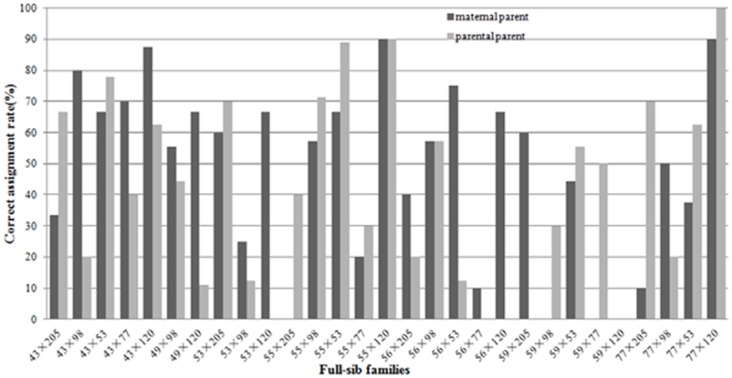
Correct maternity and paternity assignment rate of 257 control-pollinated individuals in 29 full-sib families in a Larix gmelinii var. principis-rupprechtii seed orchard.